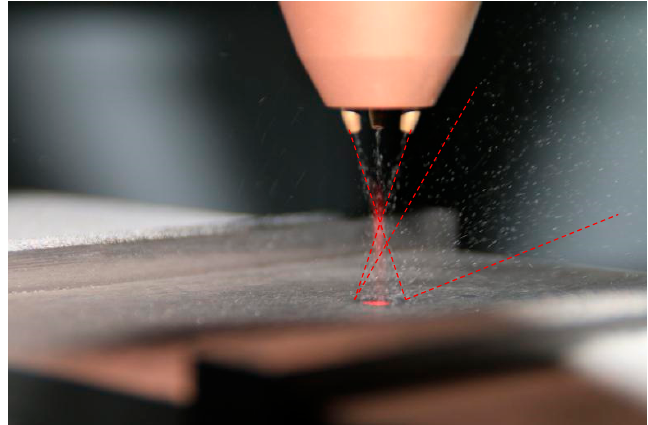
Figure 14. Powder trajectory before shot peening.